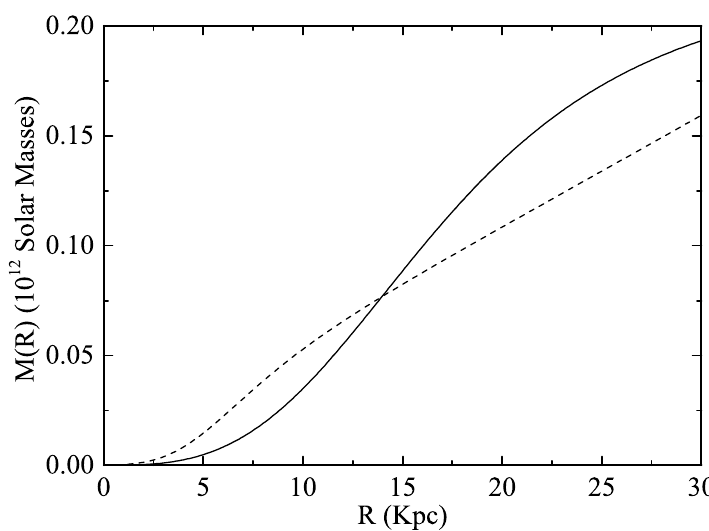
Figure 2. Mass function for the dark matter halo (solid line) vs. the mass function for the apparent dark mass in the inverse distance anomalous force model (dashed line) obtained from Equation (19). The distance scale parameter was fitted to β = 11.6